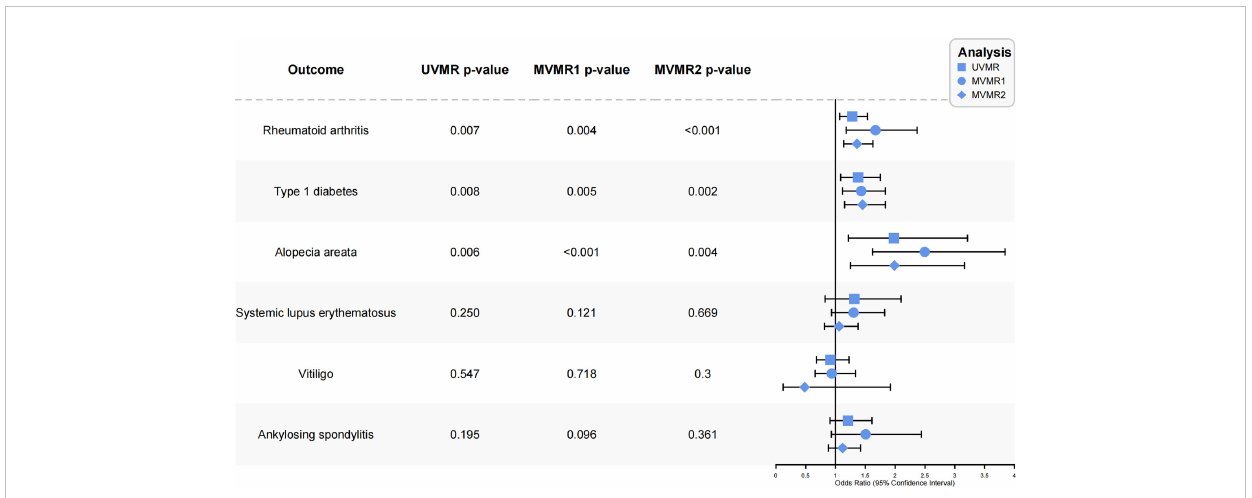
FIGURE 2 Forest plot of the causal association between atopic dermatitis and autoimmune diseases. UVMR, univariable mendelian randomization; MVMR, multivariable mendelian randomization; OR, odds